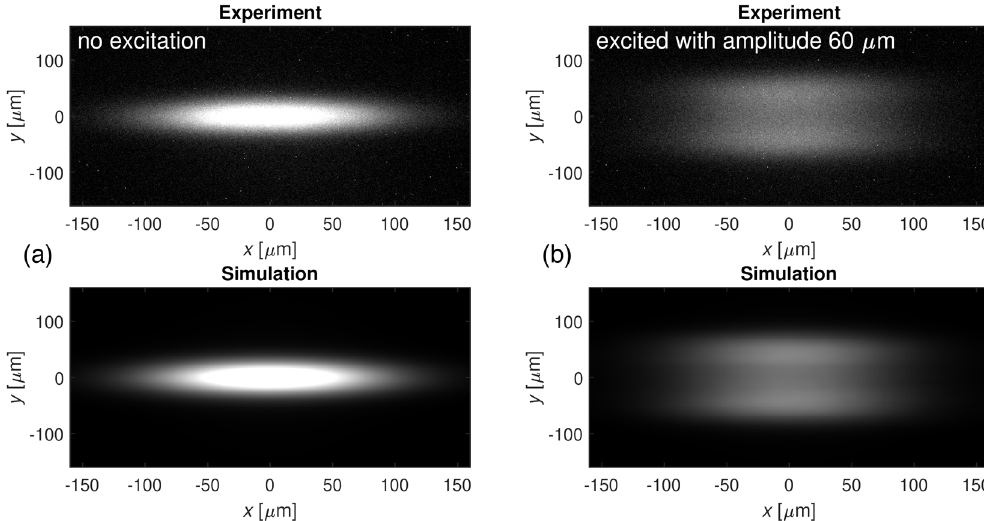
FIG. 7. Images of the pinhole camera from the experiment (top) and simulation (bottom) for (a) no excitation and (b) an excitation with an amplitude of 60 μ m, while the beam size was about 20 μ